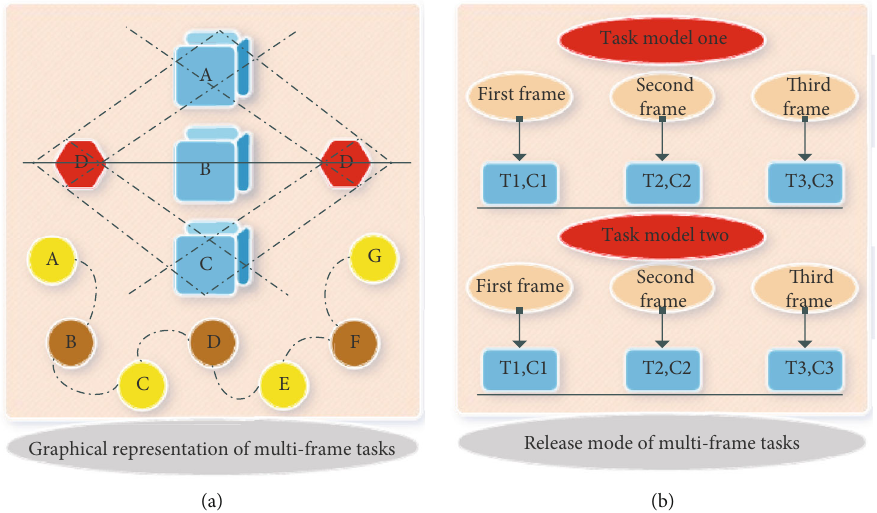
Figure 1: Graph representation and release pattern for multiframe